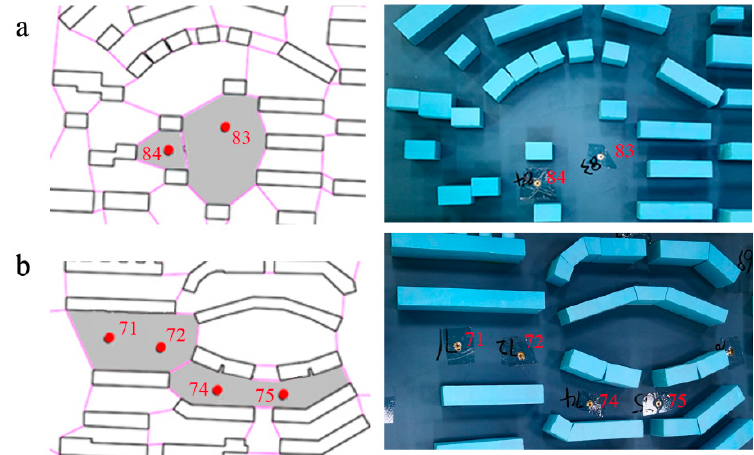
Figure 9. ( a ) Number 83 and number 84 Irwin probes located on the model. ( b ) Number 71, number 72, number 74, and number 75 Irwin probes located on the model.